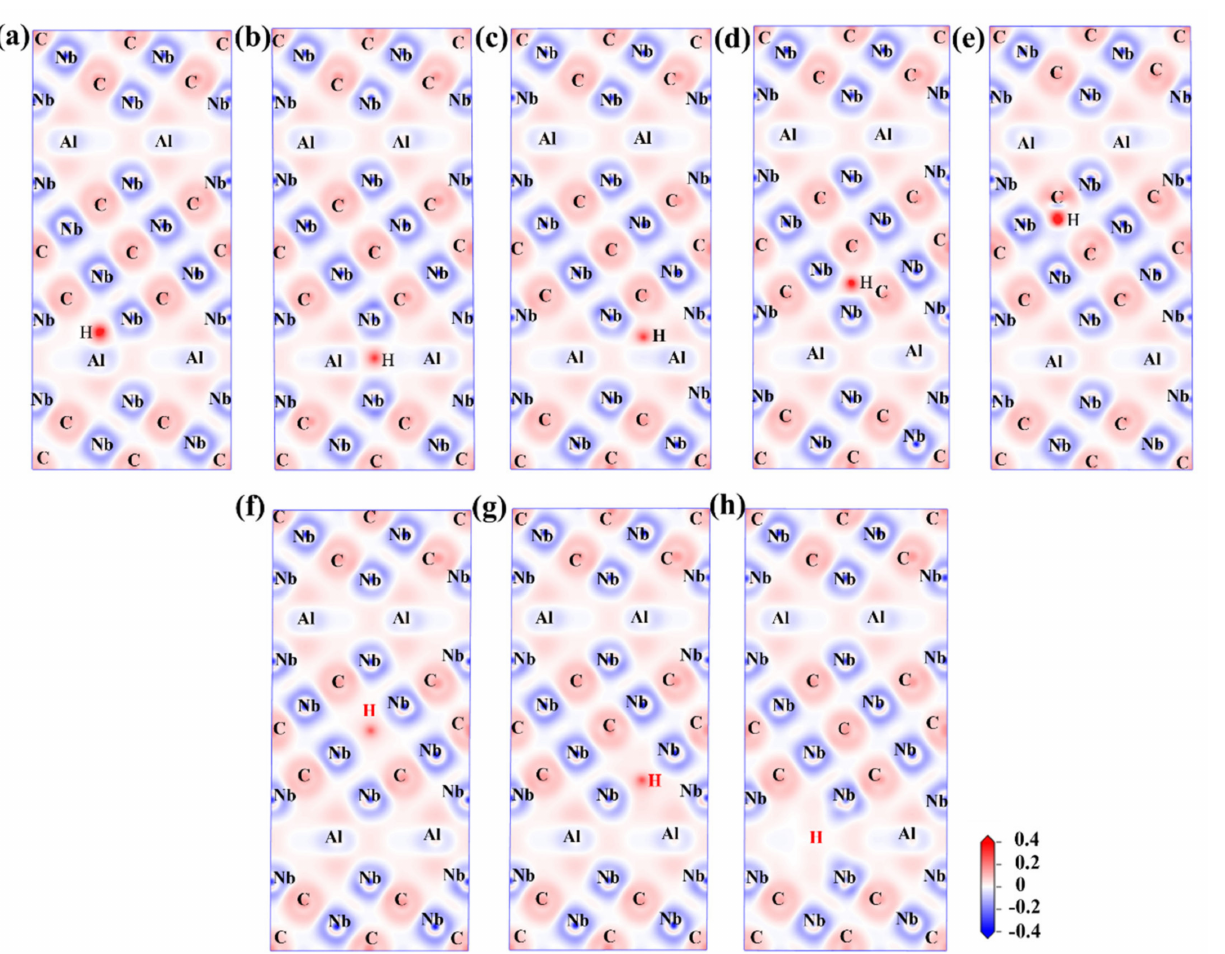
Figure 8. Two-dimensional charge density difference (CDD) plots in the (1 1 1) plane of H-doped Nb 4 AlC 3 MAX phases: ( a ) 1-site; ( b ) 2-site; ( c ) 3-site; ( d ) 4-site; ( e ) 6-site; ( f ) C(1)v; ( g ) C(2)v; ( h )